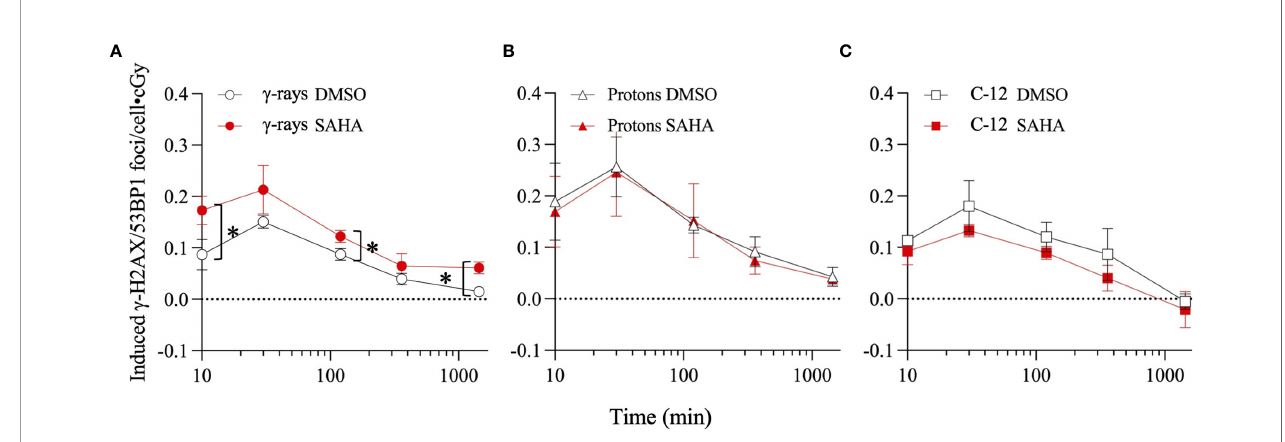
FIGURE 8 | Dose-corrected g -H2AX pS139/53BP1 foci levels in quiescent G0/G1-phase normal NFF28 primary fi broblasts pretreated for 18 h with 0.1% DMSO (vehicle control) or 10 µM SAHA measured by immunocytochemistry/image analysis in samples fi xed 10 min to 24 h post-irradiation following low dose (5 – 25 cGy) exposures of cesium-137 g -rays (A) , 200 MeV protons (B) , and 290 MeV/n C-12 ions (C) . Peak foci formation occurs at 30 min post-IR for all three radiation qualities. Data reported as IR-induced means ± SD, background-subtracted for foci levels measured in sham-irradiated cultures (indicated by dashed line). Asterisks mark signi fi cant differences compared to DMSO controls at p -values of ≤ 0.05 (*) by two-tailed Student ’ s t